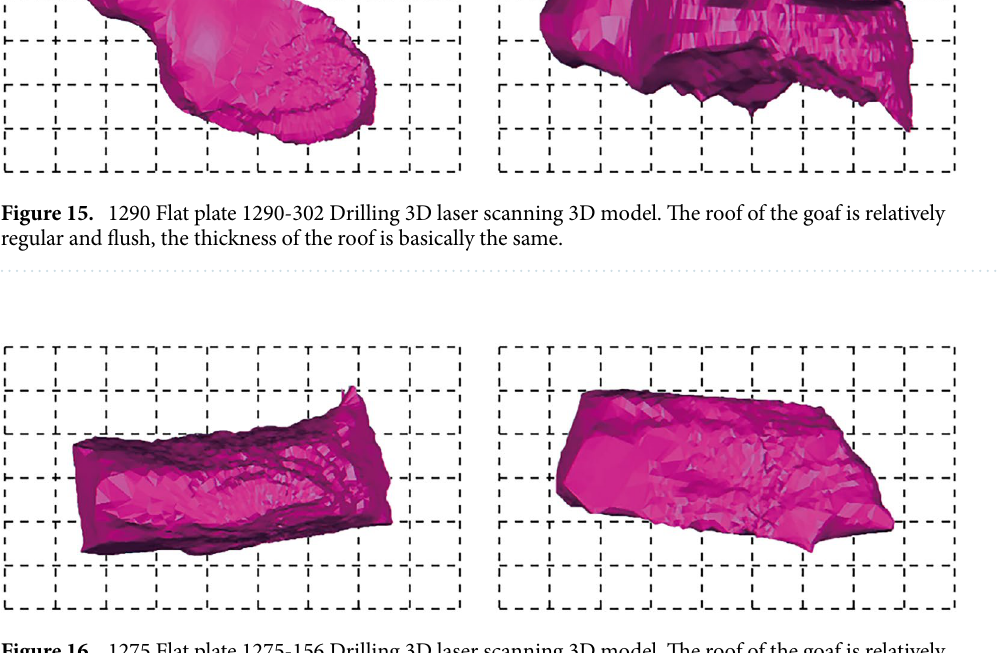
Figure 16. 1275 Flat plate 1275-156 Drilling 3D laser scanning 3D model. The roof of the goaf is relatively regular and flush, the thickness of the roof is basically the